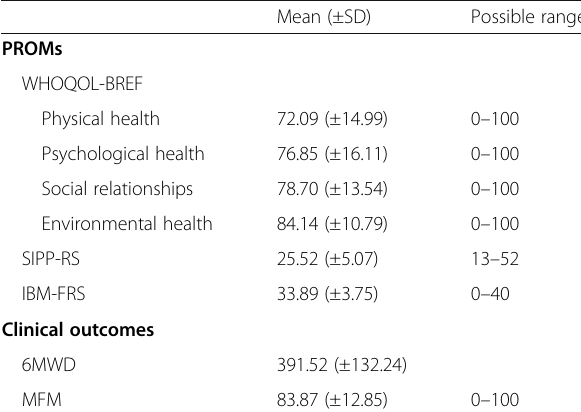
Table 1 Summary of PROMs and clinical outcomes at